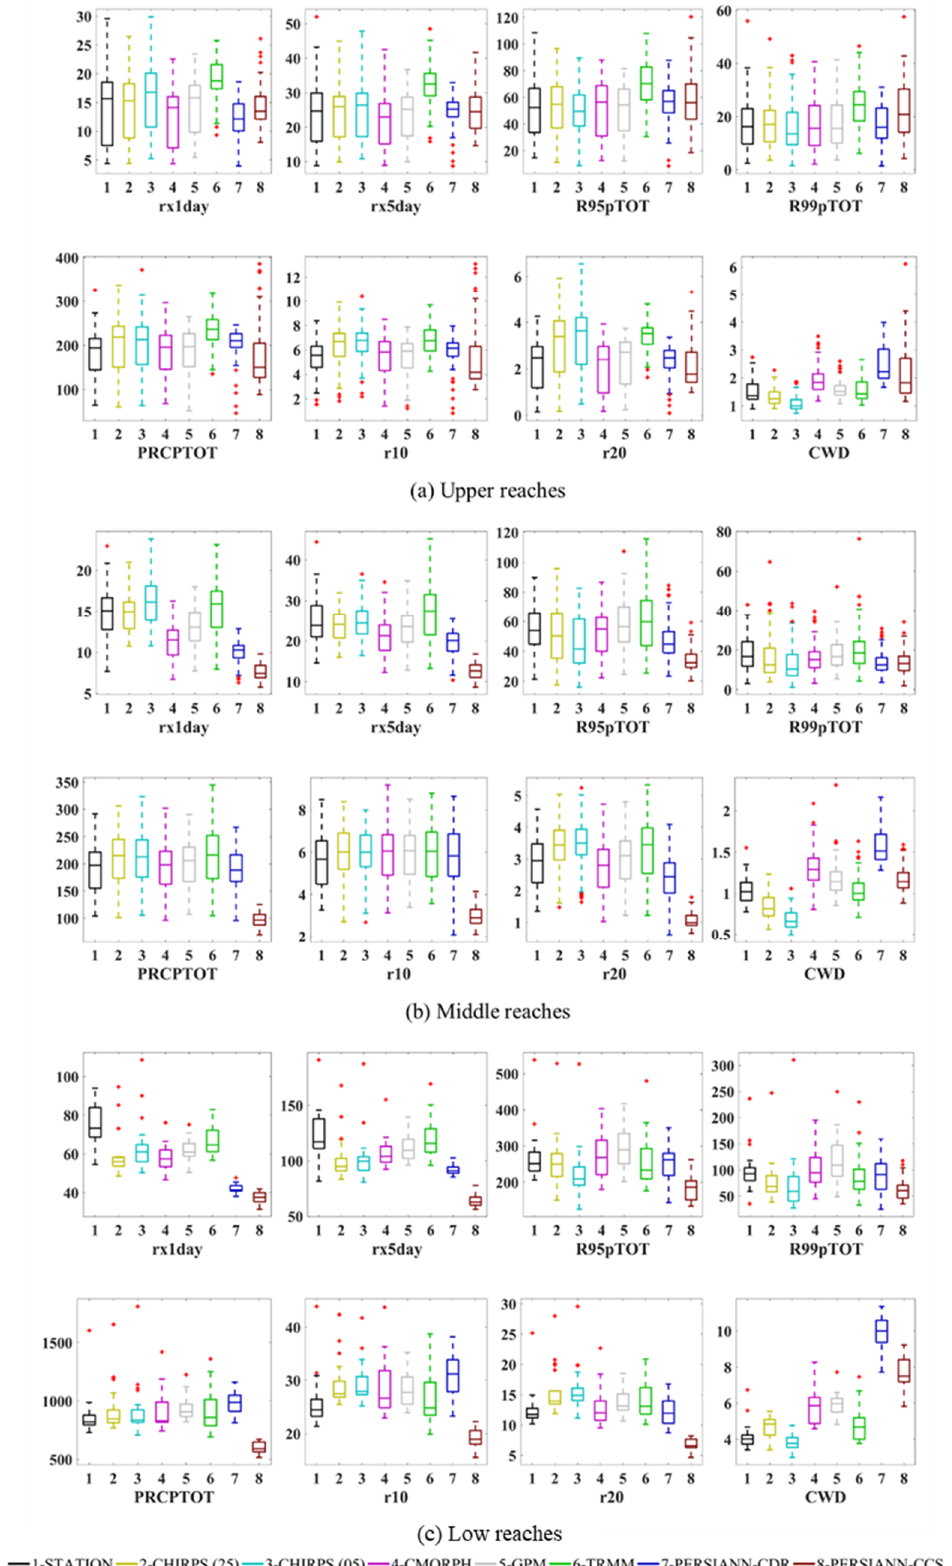
Figure 6. Comparisons of eight precipitation indexes obtained from SPPs with those from gauge observations.